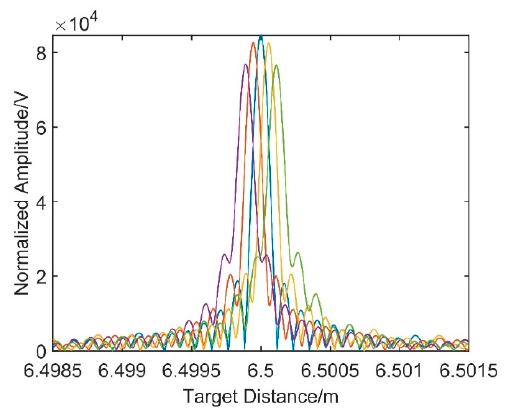
Figure 4. Simulation result based on resampling dispersion compensation method.